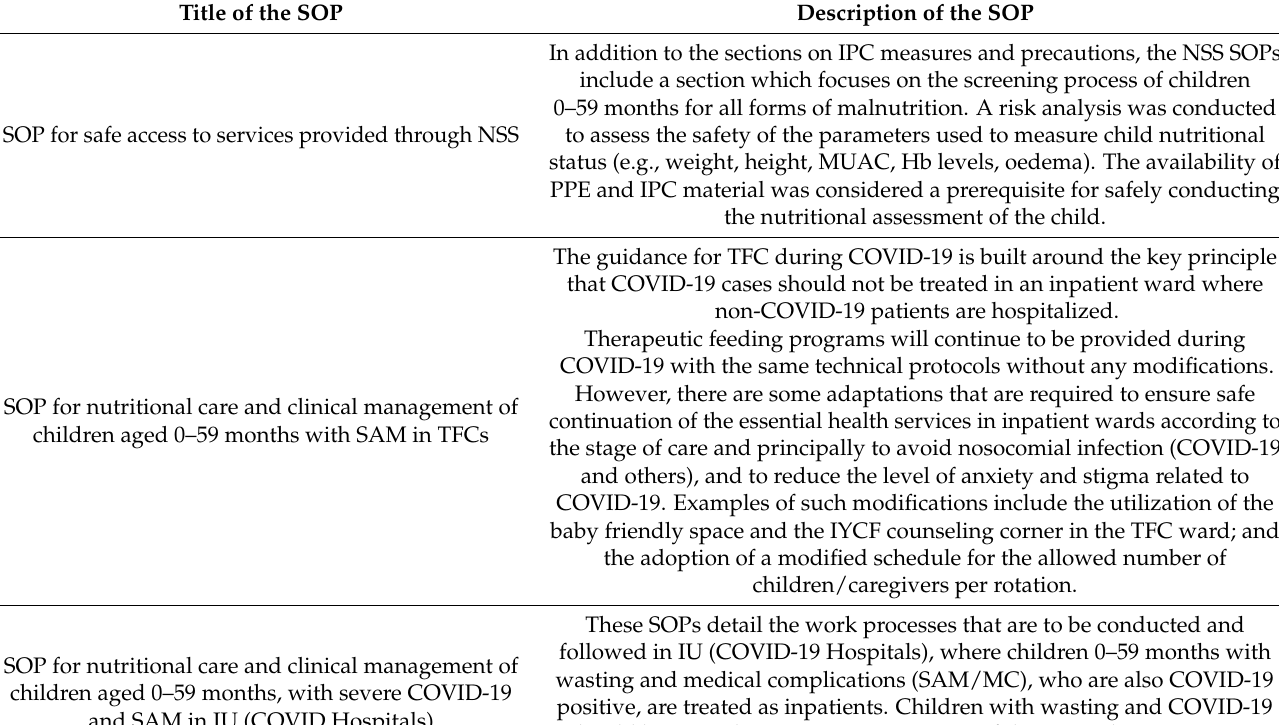
Table 3. Description of the developed SOPs within the nutrition program adaptation in